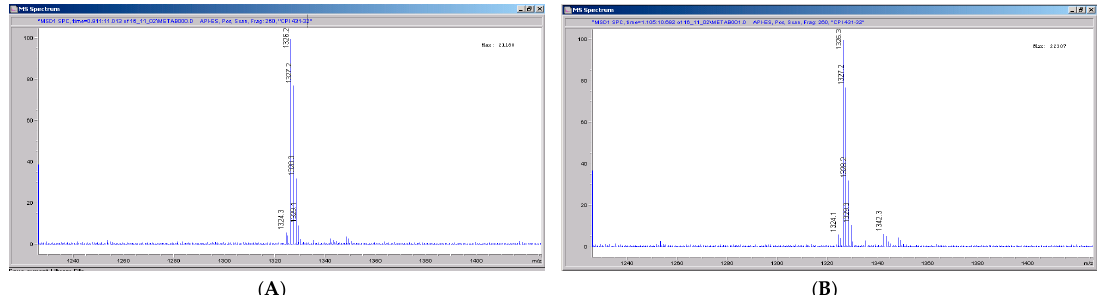
Figure 6. Mass spectral scans of human liver extracts incubated with CRV431. Human liver microsomes (1 mg/mL) were incubated with 1 μ g/mL CRV431, and extracts were removed for analysis by electrospray ionization liquid chromatography mass spectrometry (ESI-LCMS) at 20 min (panel ( A )), mass spectral scan from 1260–1460 m / z and 80 min (panel ( B )), and mass spectral scan from 1260–1460 m / z (not shown).